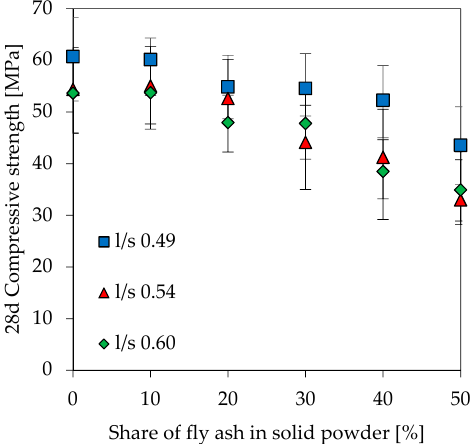
Figure 6. Compressive strength of geopolymer samples after 28 days of curing.